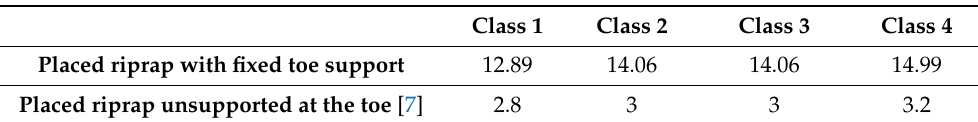
Table 5. Details of safety factors computations for 4 consequence classes for placed riprap with toe support and unsupported at the toe [7].